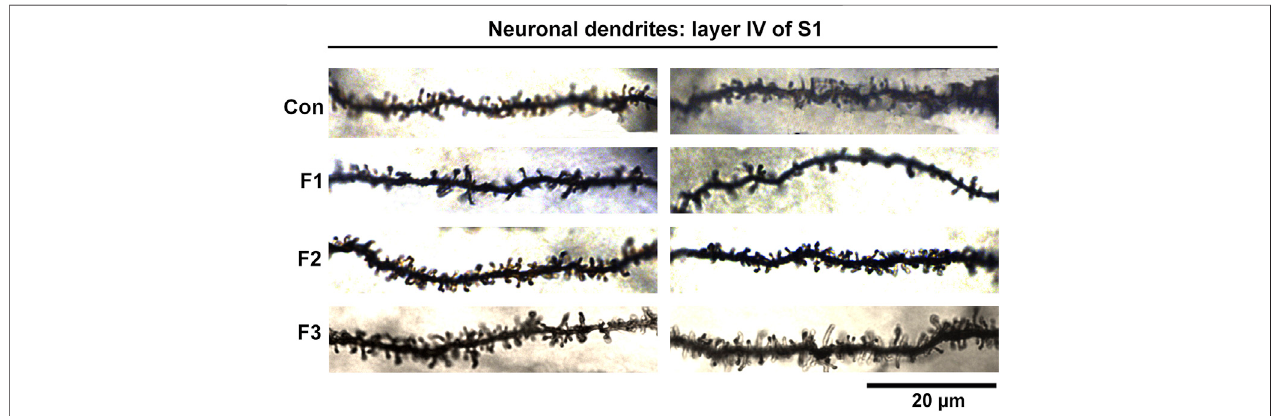
FIGURE 8 | Neuronal Dendrites within layer IV of S1. Two example dendrites are shown for each experimental group originating from separate animals. For Controls: 2 males displayed; For F1: 1 male, 1 female displayed; For F2: 2 males displayed; For F3: 1 female, 1 male displayed. A notable reduction in the number of spines in F1 mice can be observed. Scale bar, 20 μ m.